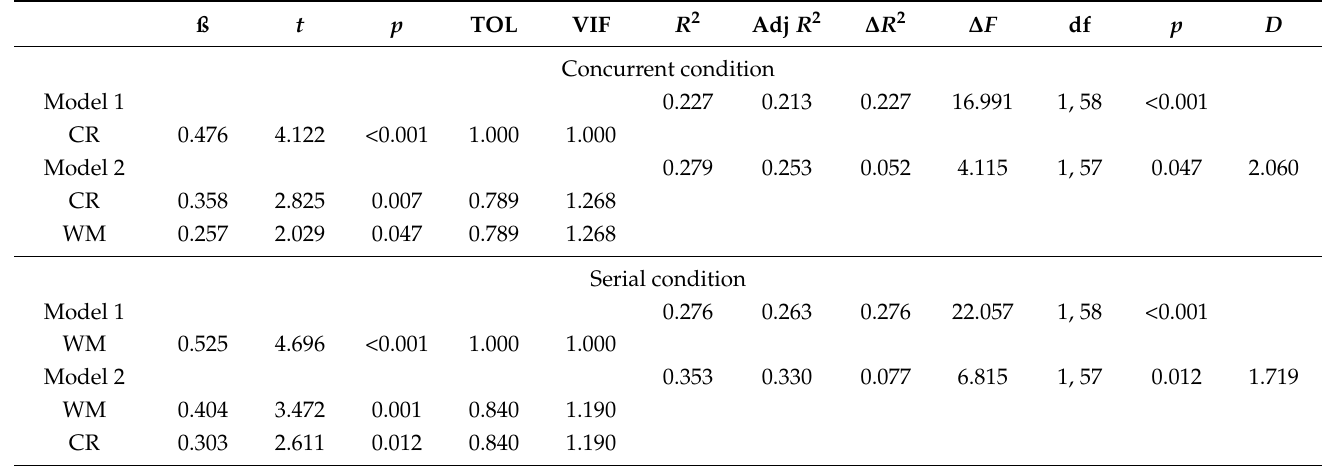
Table 8. Results of the stepwise regression analyses for two-proposition